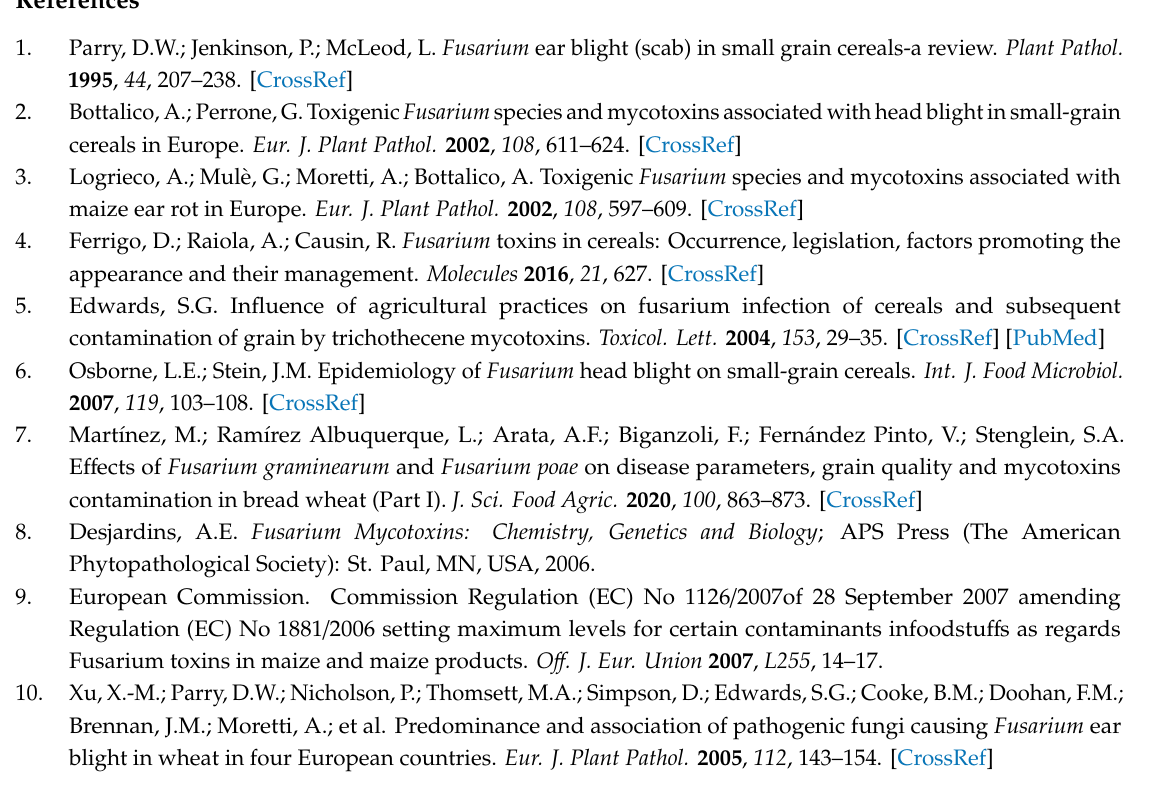
F. poae ( Fp ), F. tricinctum ( Ft ) and F. langsethiae ( Fl ) of the lowly to moderately susceptible cultivar of the seven trial locations (three replications per location) in northern Germany from 2013 to 2017 and across years. n = 105; Figure S1: Boxplots and means (white rhombus) of (a) DNA amounts of F. graminearum ( Fg ), F. culmorum ( Fc ), F. avenaceum ( Fa ), F. poae ( Fp ), F. tricinctum ( Ft ) and F. langsethiae ( Fl ) (pg fungal DNA / ng plant DNA), (b) percentages of DNA amounts of the detected Fusarium species to the total Fusarium DNA amount of all detected species and boxplots and means (white rhombus) of (c) DON and ZEA concentrations ( µ g / kg) in wheat grain of the moderately to highly susceptible cultivar of the seven trial locations (three replications per location) in northern Germany from 2013 to 2017. Five statistics are represented in each boxplot from bottom to top: the smallest observation, lower quartile, median, upper quartile, and largest observation, respectively. Mean values labelled with the same letter (small or big) are not significantly di ff erent from each other ( p > 0.05). Capital letters describe di ff erences for one species and DON and ZEA concentrations between years and small letters di ff erences between the detected Fusarium species within a year. n = 105; Figure S2: Boxplots and means (white rhombus) of (a) DNA amounts of F. graminearum ( Fg ), F. culmorum ( Fc ), F. avenaceum ( Fa ), F. poae ( Fp ), F. tricinctum ( Ft ) and F. langsethiae ( Fl ) (pg fungal DNA / ng plant DNA), (b) percentages of DNA amounts of the detected Fusarium species to the total Fusarium DNA amount of all detected species and boxplots and means (white rhombus) of (c) DON and ZEA concentrations ( µ g / kg) in wheat grain of the moderately to highly susceptible cultivar of the seven trial locations (three replications per location) in northern Germany from 2013 to 2017. Five statistics are represented in each boxplot from bottom to top: the smallest observation, lower quartile, median, upper quartile, and largest observation, respectively. Mean values labelled with the same letter (small or big) are not significantly di ff erent from each other ( p > 0.05). Capital letters describe di ff erences for one species and DON and ZEA concentrations between years and small letters di ff erences between the detected Fusarium species within a year. n =